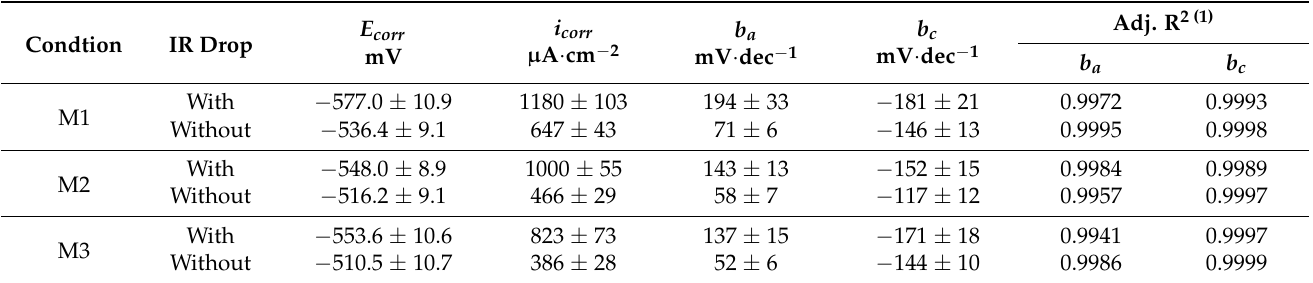
Table 3. Fitting results of polarization curves with and without an IR drop by Tafel extrapolation under three measurements in HCl solutions after exposure for 2 h.